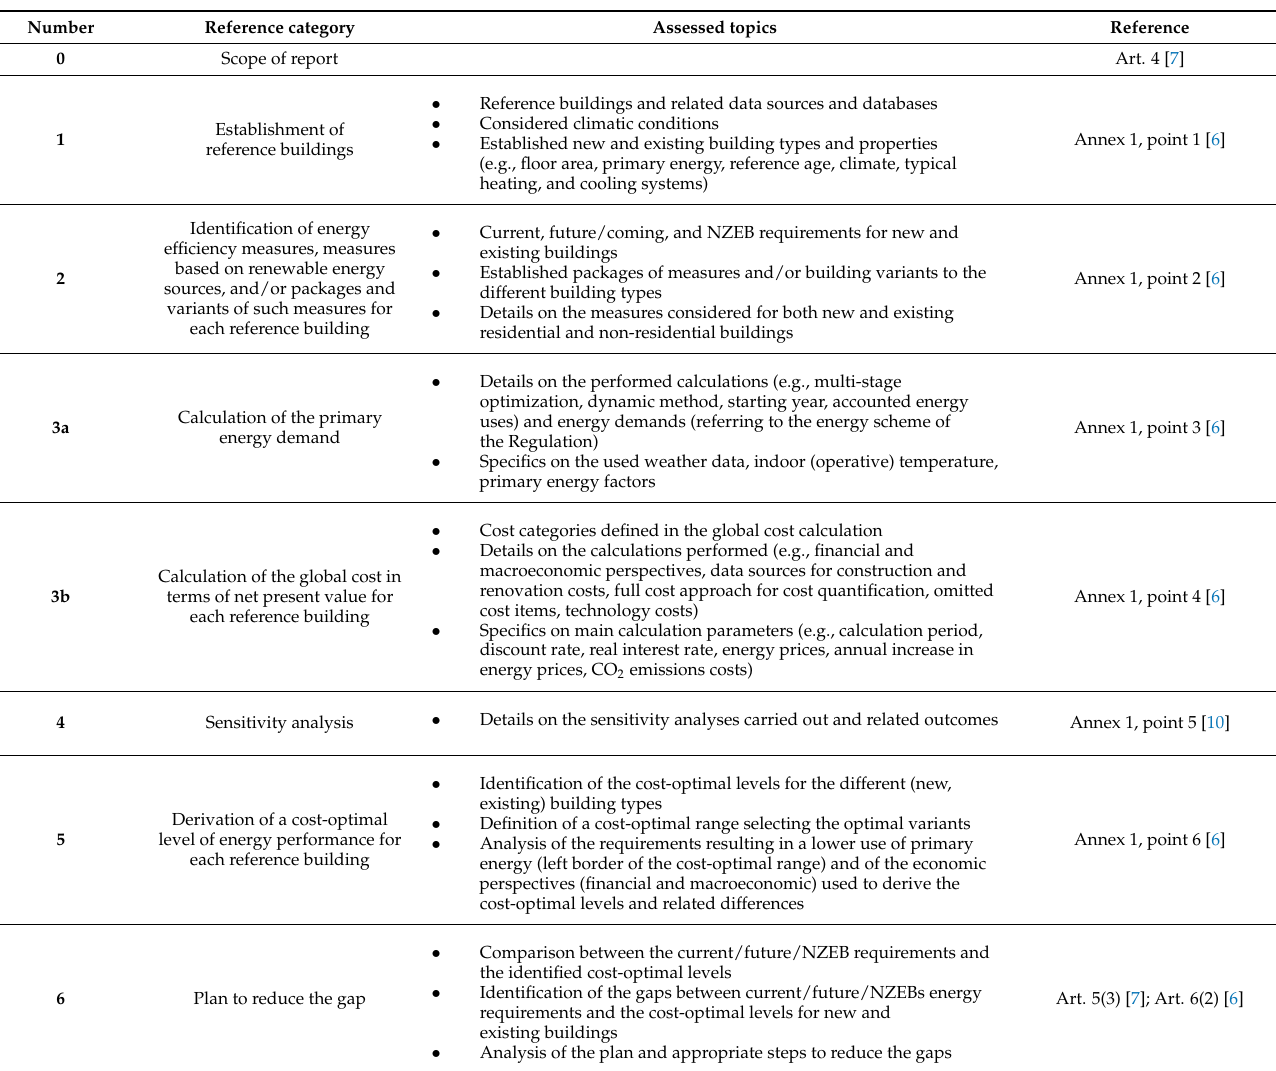
Table 1. Reference